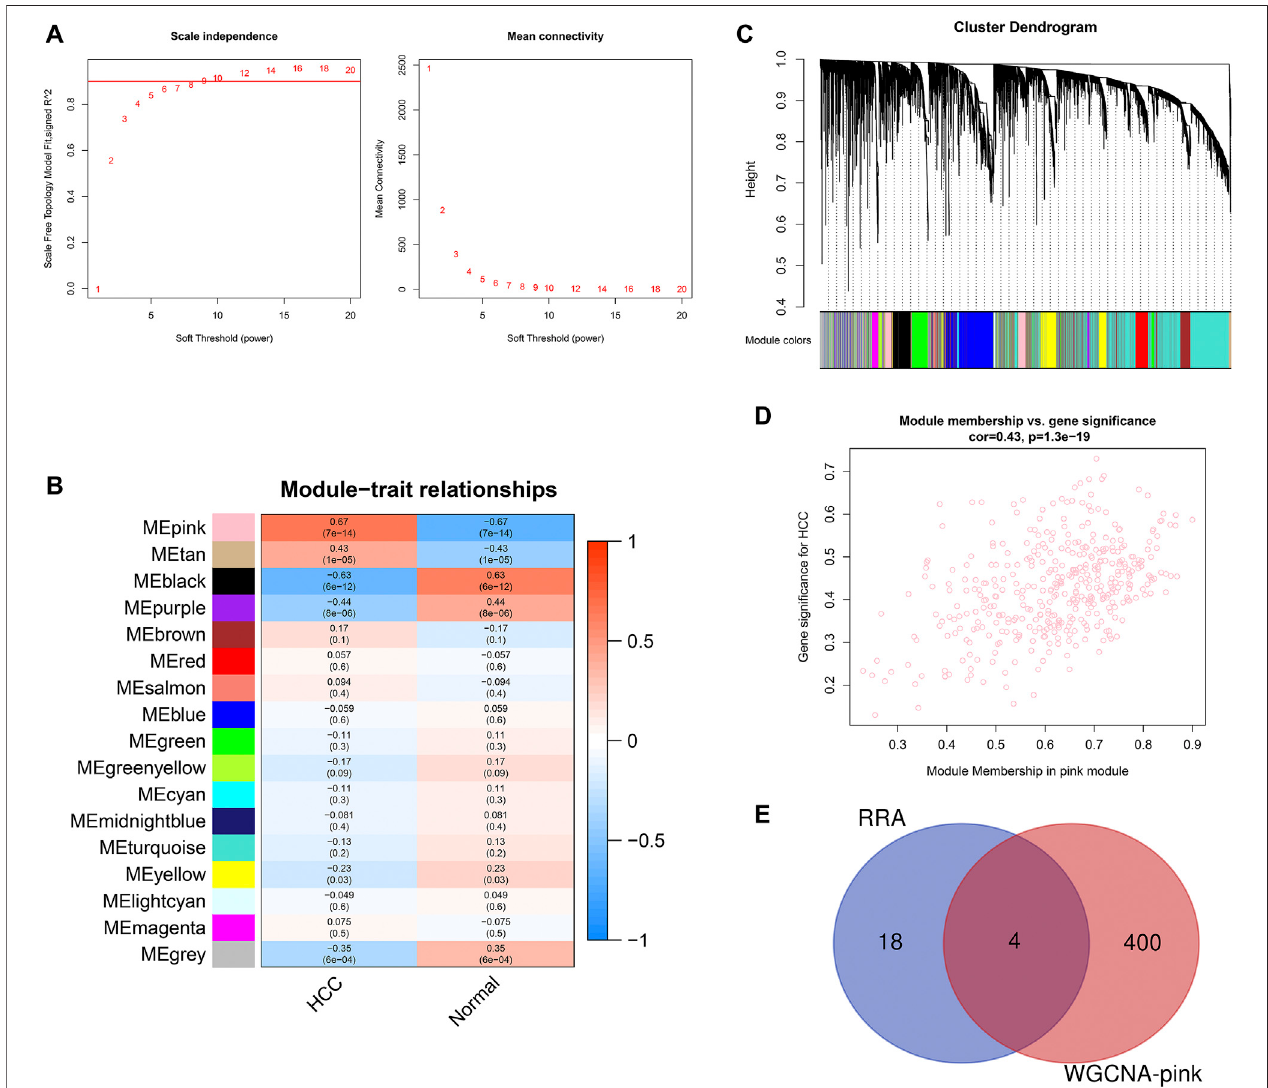
FIGURE 4 | Identi fi cation of key module associated with HCC in the GSE155949 dataset using WGCNA analysis. (A) Determination of the best soft threshold (power).Whenpower (cid:1) 6,thescale-free R 2 > 0.8andmeanconnectivity < 100. (B) Clusterdendrogramofco-expressioncircRNAsmodules. (C) Relationshipsbetween different modules and HCC tissues. The corresponding correlation coef fi cient and p -value are presented in each cell. (D) Scatter plot of gene signi fi cance and module membership in the pink module. (E) Venn diagram of the overlapping circRNAs identi fi ed by the RRA algorithm and WGCNA analysis. RRA, robust rank aggregation; WGCNA, weighted gene co-expression network analysis.